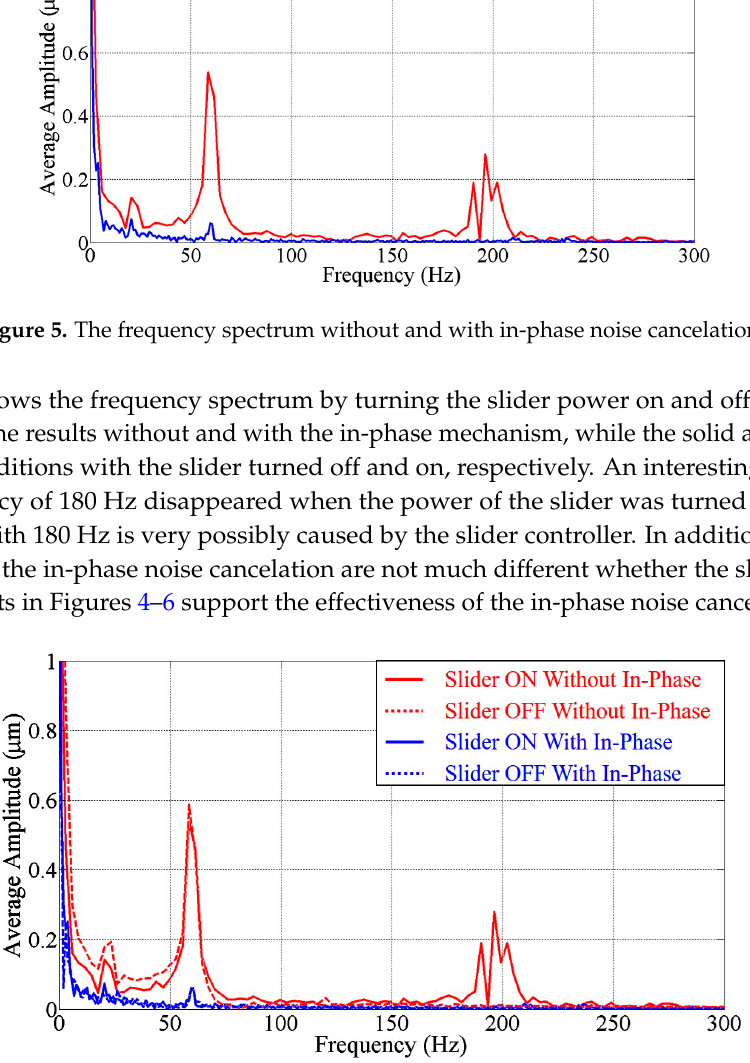
Figure 6. The frequency spectrum without and with the slider motor power turning on.